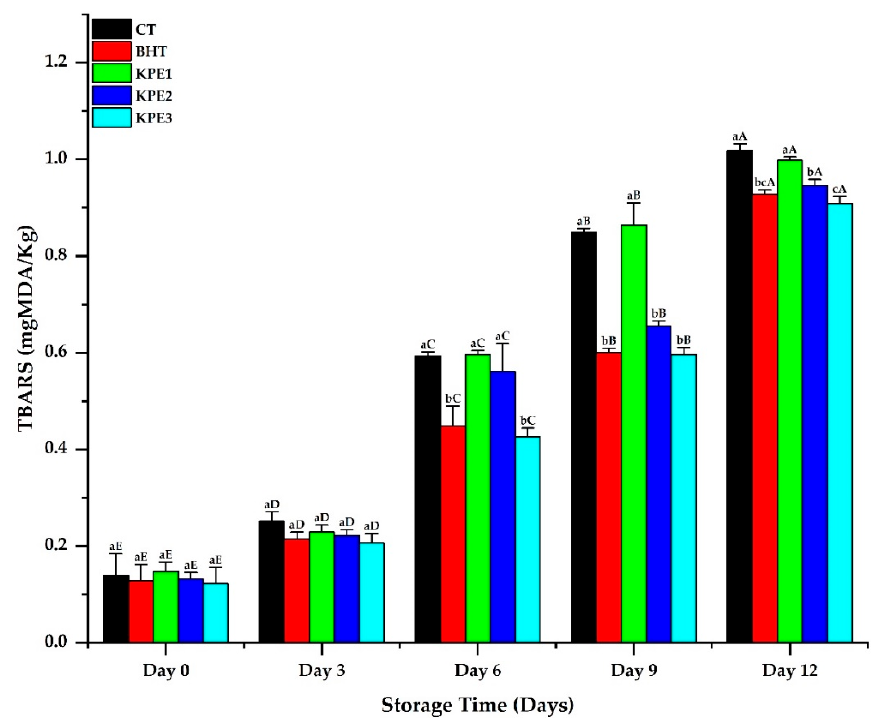
Figure 1. TBARS results of beef sausages during 12 d of refrigerated storage. Values are mean ± SE (n = 3). a–c Means values are significantly different ( p < 0.05) across the treatments, while A–E means values are significantly different ( p < 0.05) across the storage duration. CT: (0% KPE), BHT: (0.01%), KPE1: (1.5%), KPE2: (3%), and KPE3: (4.5%) stored at 4 ± 1 °C for 12 d.